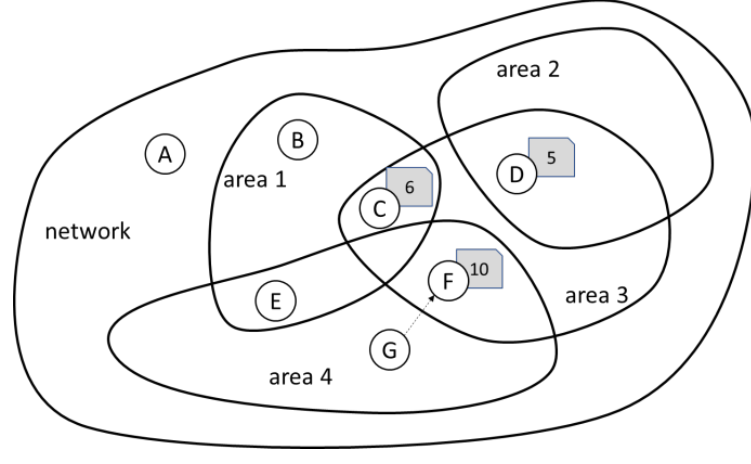
Figure 1. The network and its areas of interest.